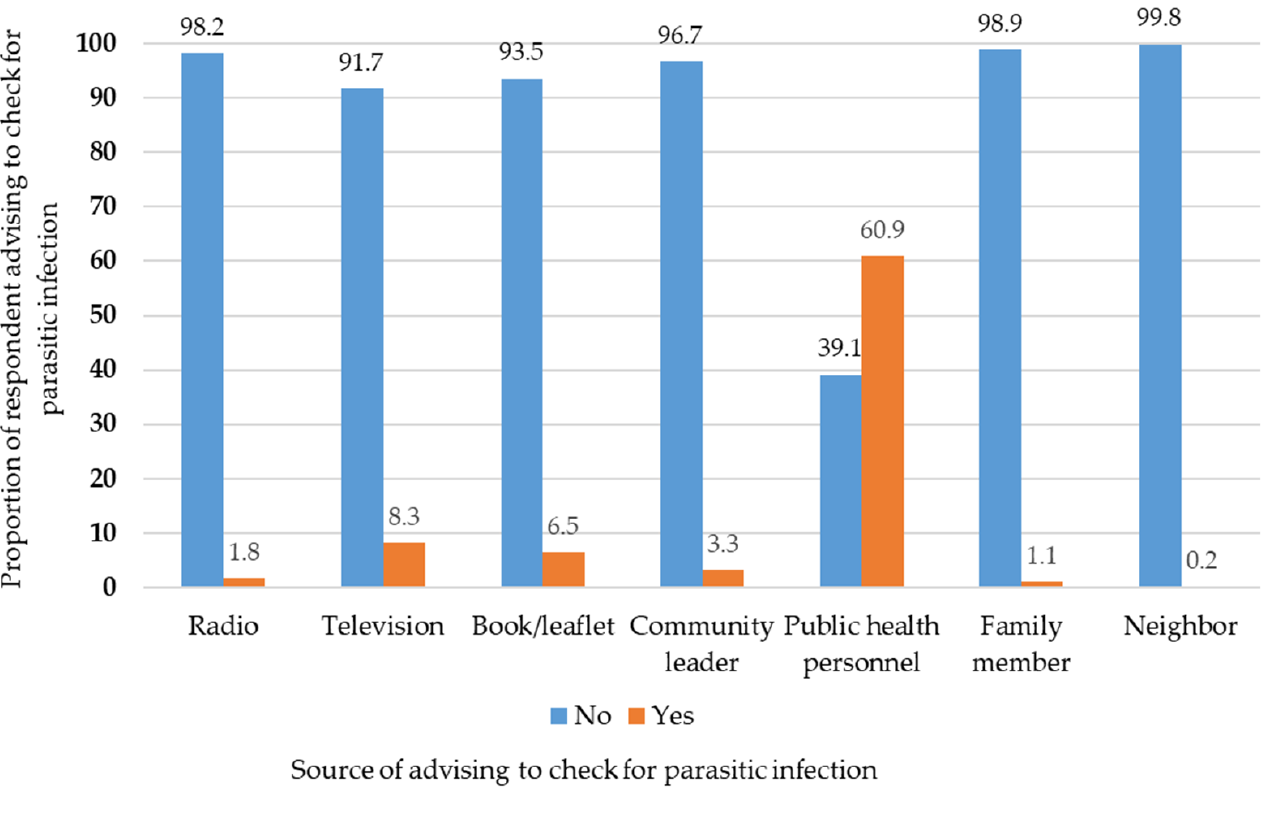
Figure 3. Proportion of respondents advised to check for parasitic diseases by source of advice. Table 7. Univariate and multivariate mixed-effect logistic regression analysis of factors associated with source of gaining knowledge about soil-transmitted